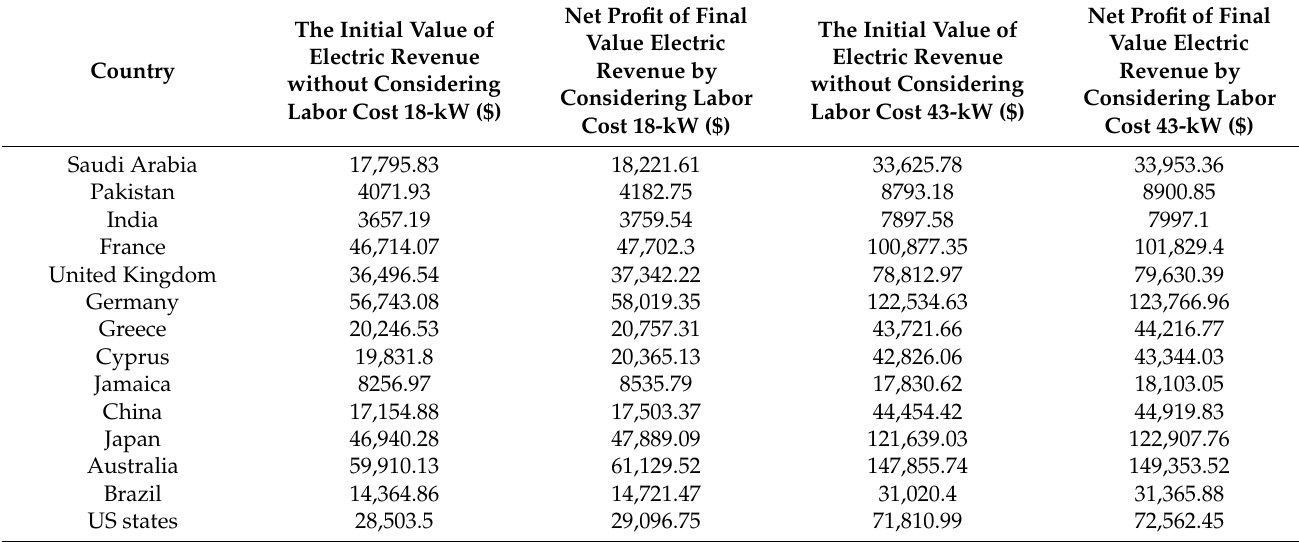
Table 8. The original and final rate returns of electric revenue associated with the two types of 10 × 10 PV arrays, taking into account the greatest annual economic